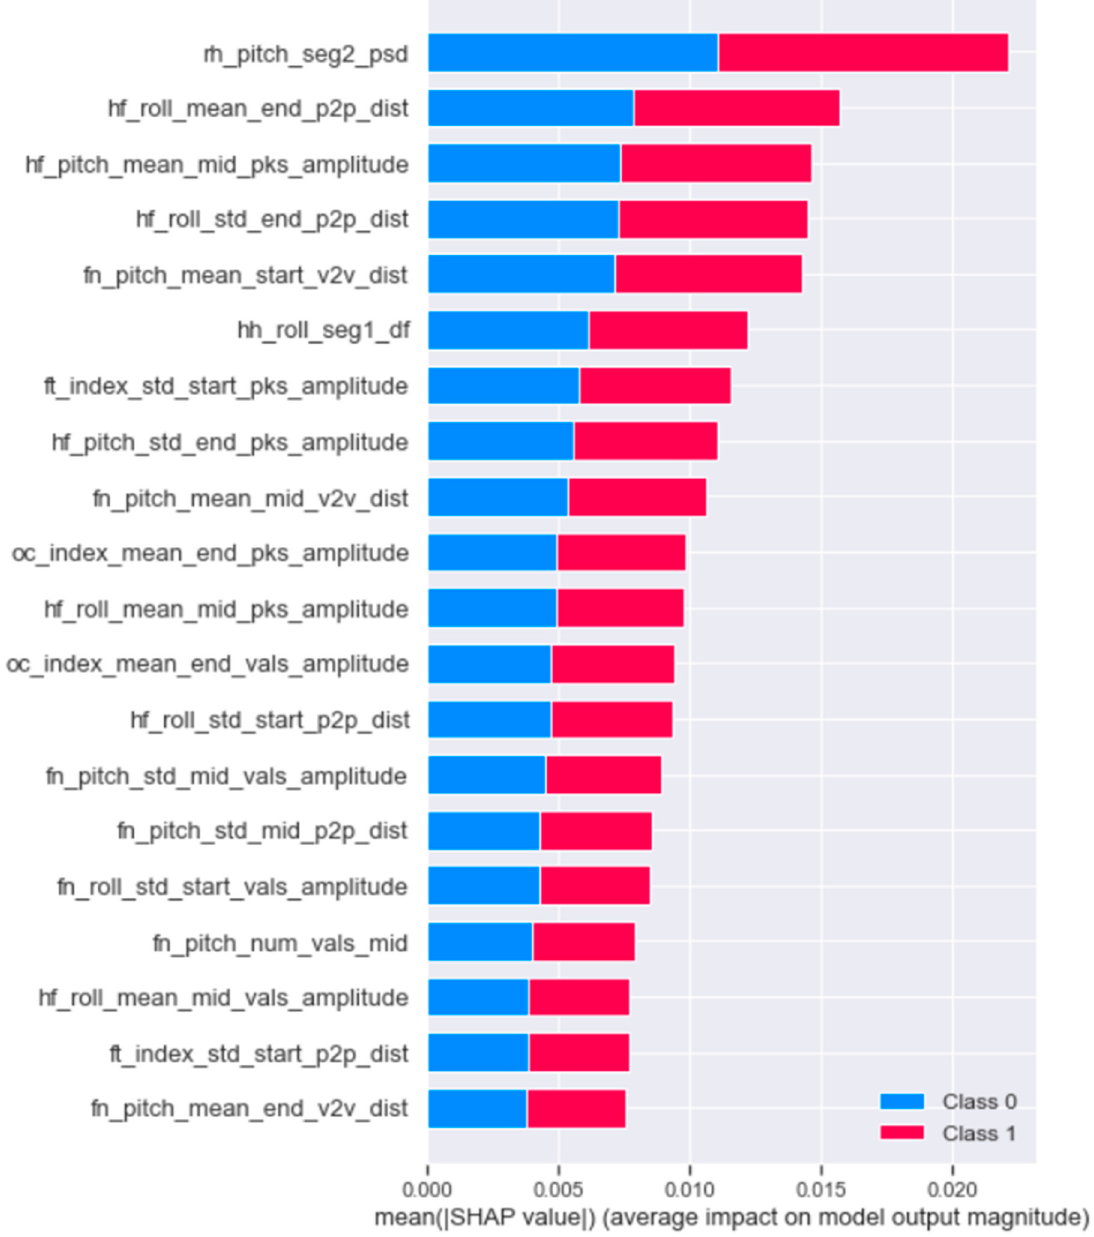
Figure A1. SHAP feature importance for top 20 features from left and right glove data for medication state classification.